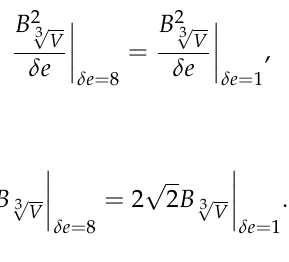
Figure 6. Axial pressure profile comparisons for meshes with δ e = 1 mm and δ e = 8 mm. When B 3 √ B 0 is used, the meshes with δ e = 8 mm (Curve 2) predict a higher pressure gradient than that of √ = 2 δ e = 1 mm (Curve 1). By setting B 3 √ 2 B 0 for the mesh with δ e = 8 mm (Curve 3) or using V = B 0 √ B y for both meshes (Curves 4 and 5), the predicted pressure gradients are close to Curve 1. p 10 ( a ) B 0 = 30; ( b ) B 0 =